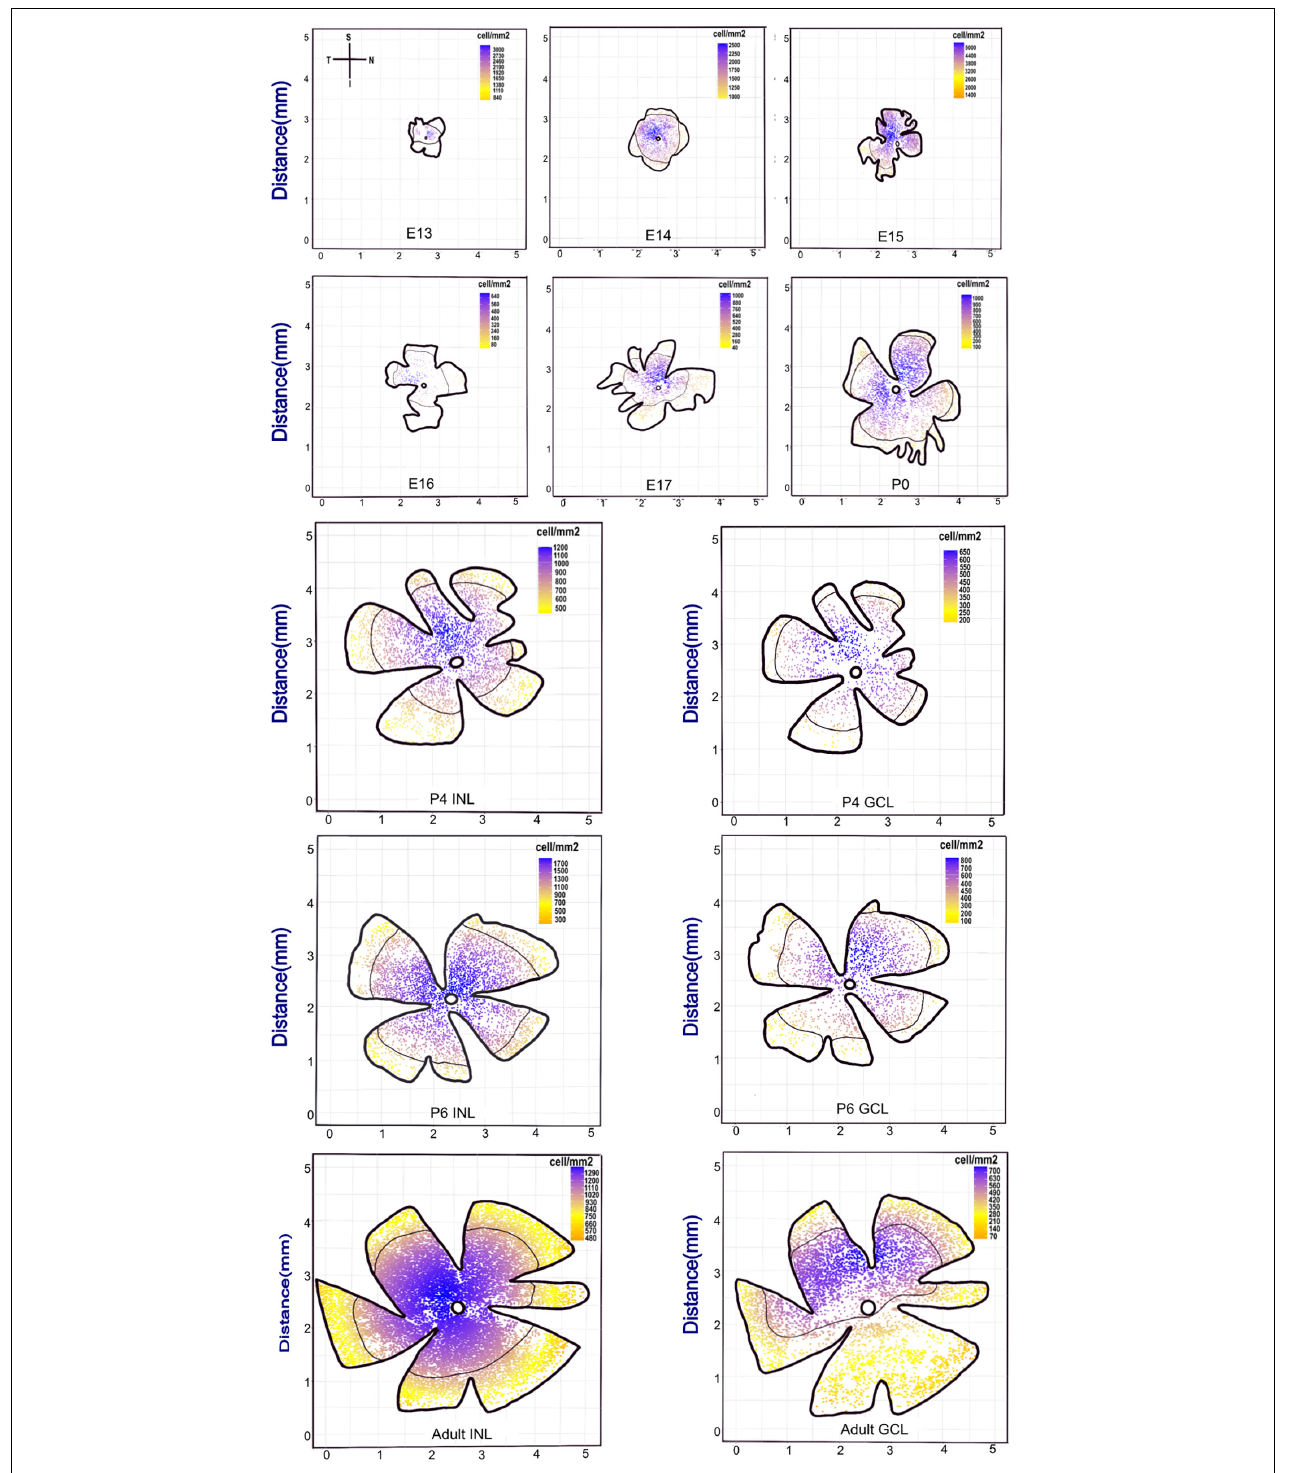
FIGURE 2 | Retina whole-mount view showing that the POMC-positive cell distribution has a changeable dense pole. The coordinate axis indicates the actual retina size. From E13 to the adult stage, the retina whole-mount size became larger. Each retina was seated as superior to the upside and nasal at the right side. The scale bar represents the POMC-positive cell density for each retina. Blue represents the denser part, and yellow represents the sparse part. The black line shows the mean density contour line. E13 to P0 had only one layer, whereas P4, P6, and adult had two layers. The dense pole was always located in the superior retina from E13 to P6. However, from P6, the INL dense pole transferred to the optic disc, and the GCL pole was still in the superior retina.